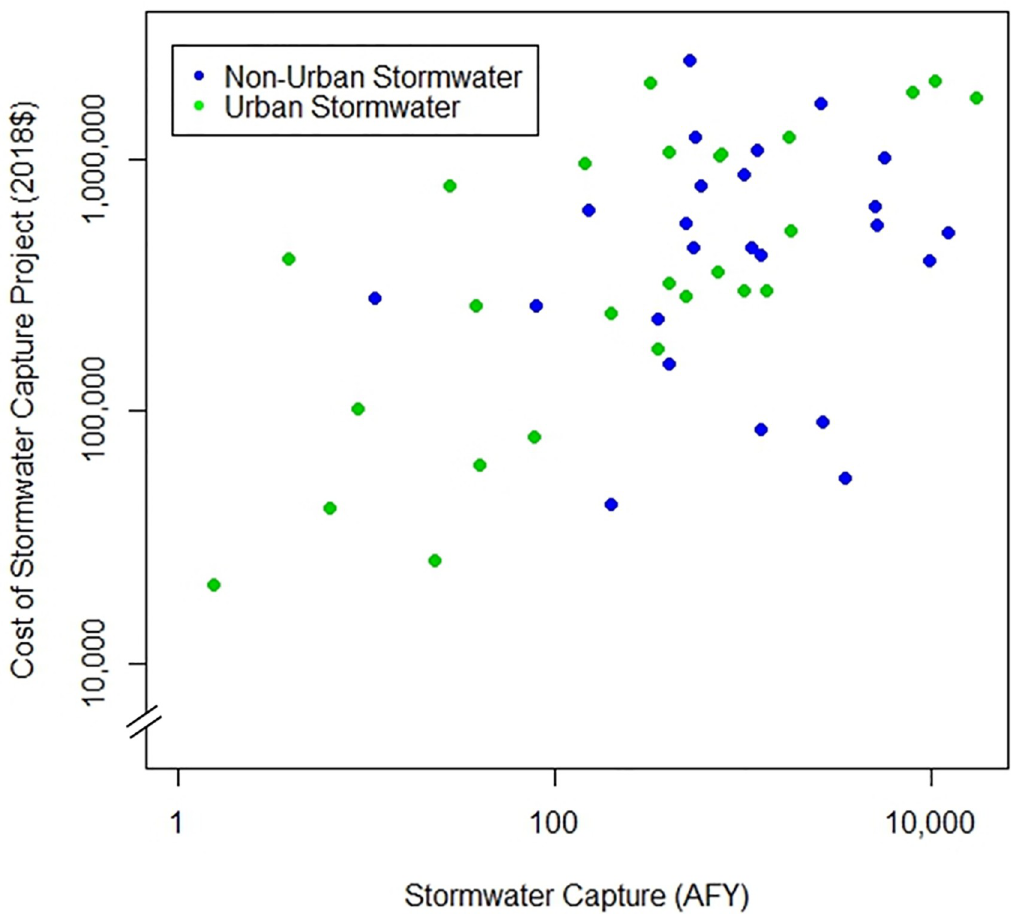
Fig 3. Scatter plot of stormwater capture volume (AFY) by levelized cost of water ($/AFY) in log-log scale for urban stormwater capture projects (green) and non-urban stormwater capture projects (blue).